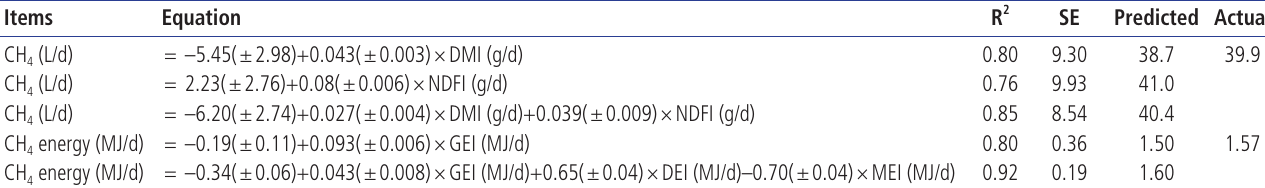
Table 3. Linear and multiple regression for CH4 output using feed intake and energy digestibility and metabolisability Items